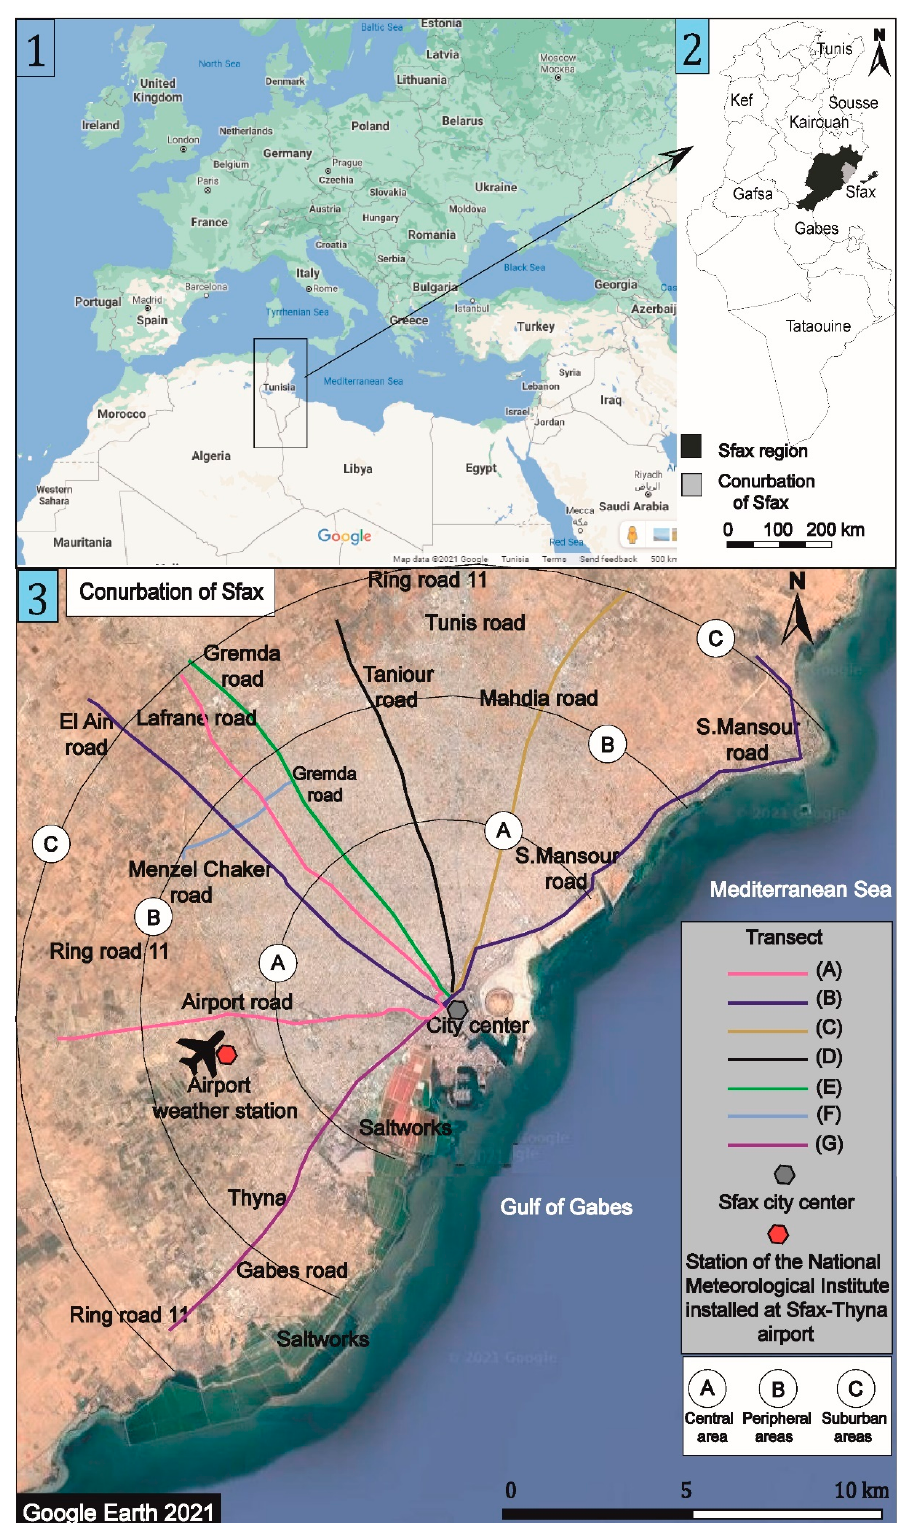
Figure 1. ( 1 ) Location of Tunisia in North Africa on the southern shore of the Mediterranean (back- ground, Google Maps 2020); ( 2 ) location of the region and conurbation of Sfax in central-eastern Tunisia; ( 3 ) the conurbation of Sfax and the urban transects on which the mobile survey campaigns were carried out (background, Google Earth 2020).